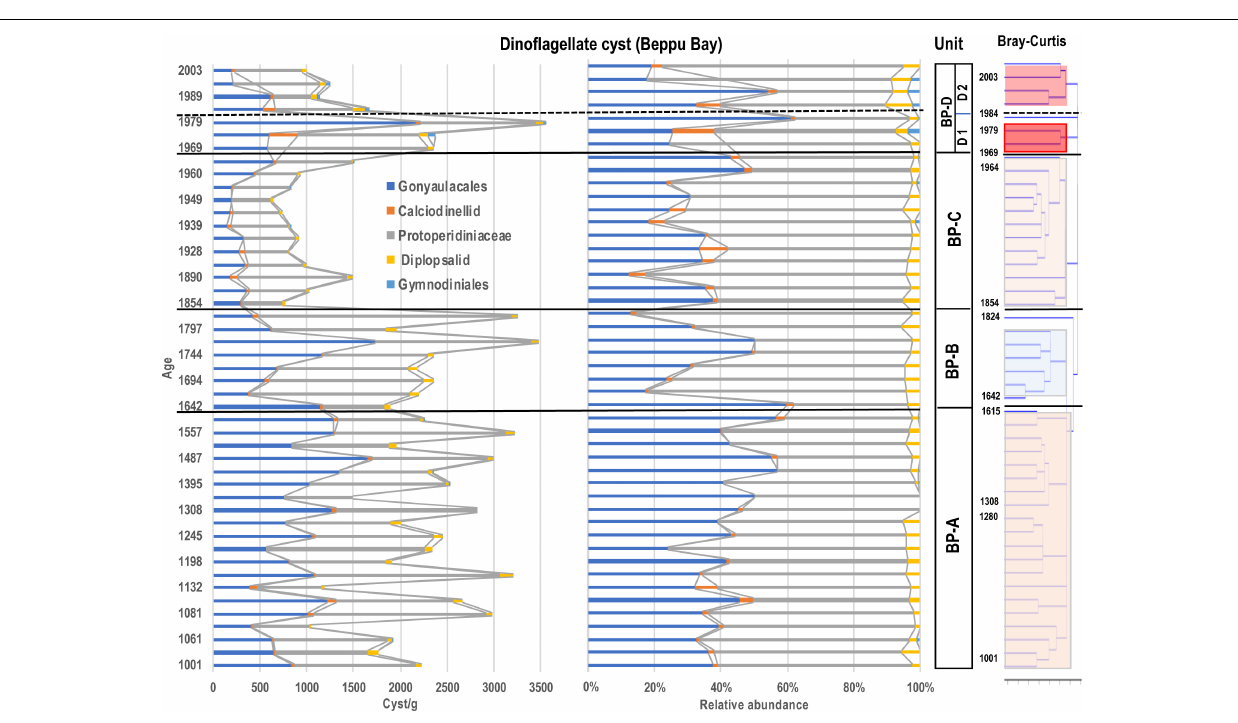
FIGURE 6 | Stratigraphic abundances of dinoflagellate cysts and Unit division based on stratigraphic cluster analysis using Bray-Curtis method.